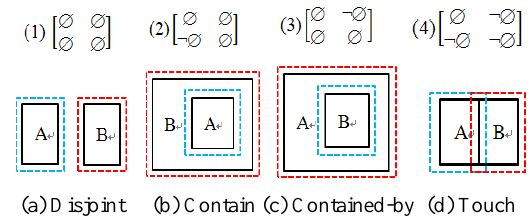
Figure 4. Three different topological relations.